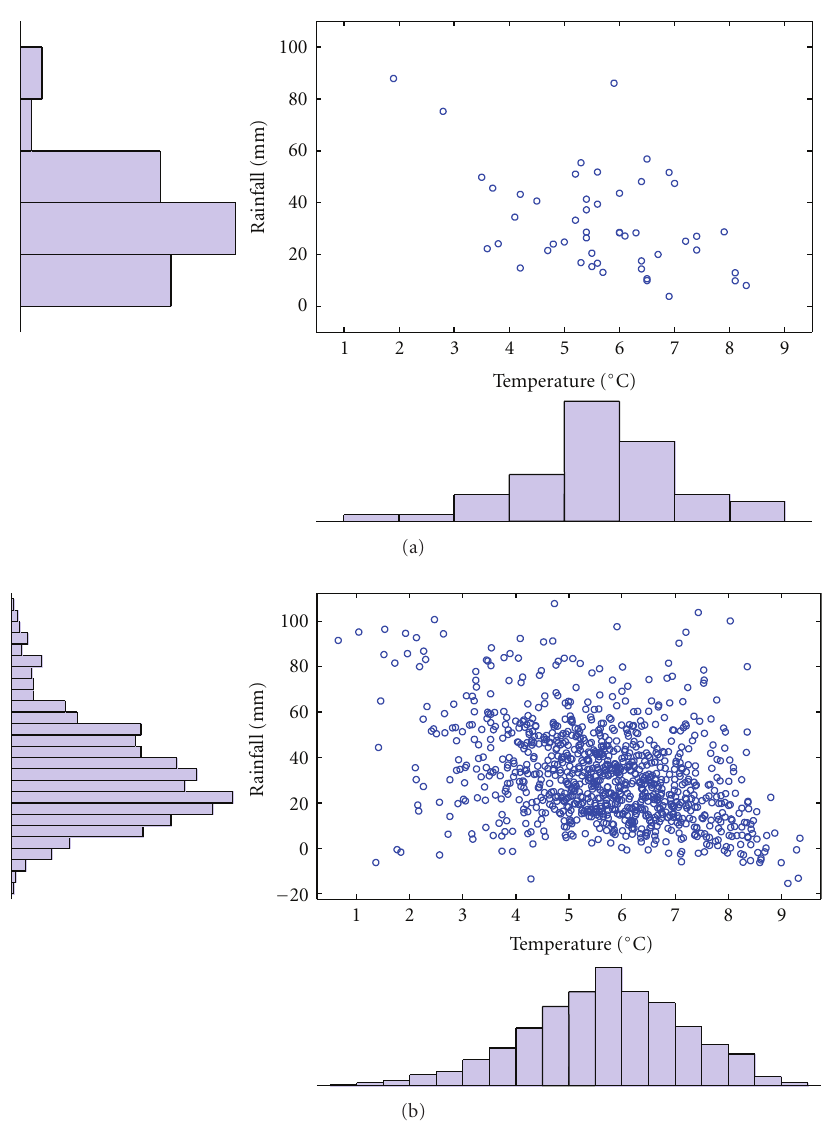
Figure 14: Real (a) and student-based copula simulated (b) temperature and rainfall data for Scania in